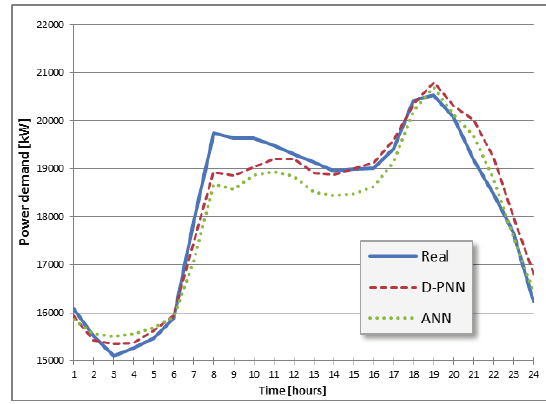
Fig. 13. IESO : 3.2.2012 (Friday). D-PNN RMSE = 404.2 , ANN RMSE = 501.9